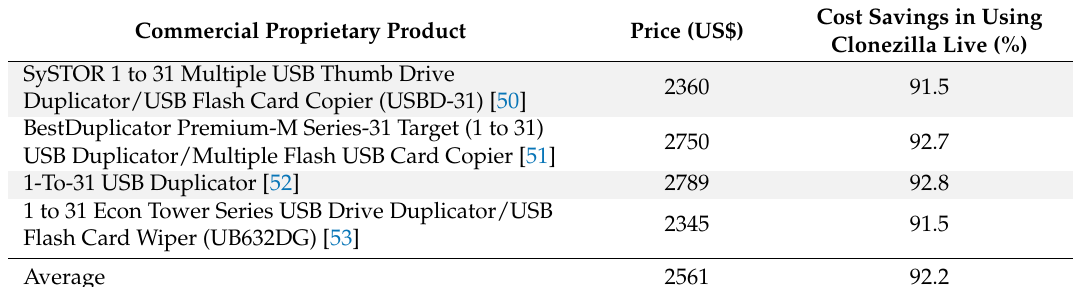
Table 4. Commercial USB flash drive duplicator cost and cost saving percent for using Clonezilla